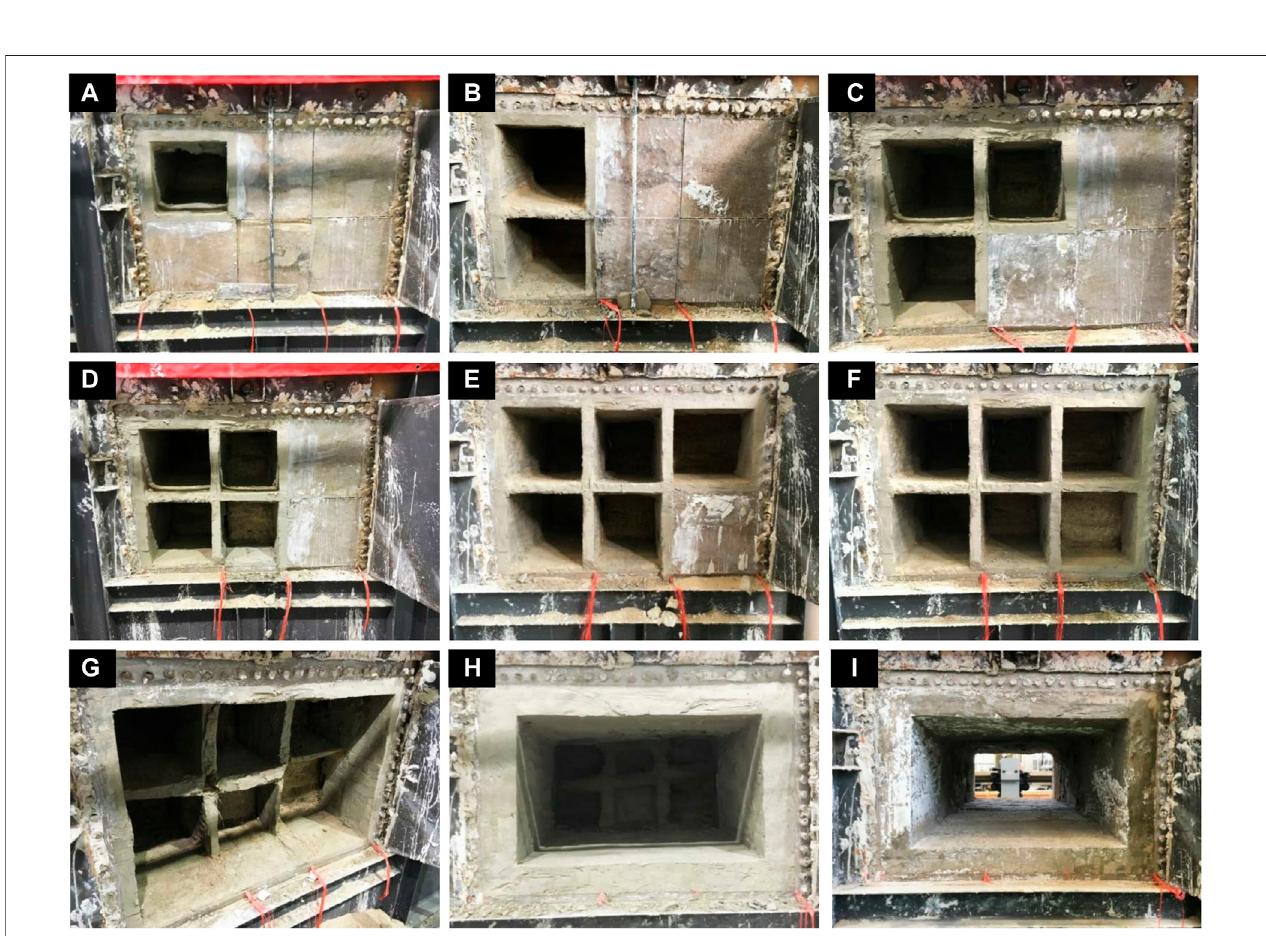
FIGURE9| Experimentalexcavationand primarylininginstallation: (A) Excavationofdrift1; (B) Excavationofdrift2; (C) Excavation ofdrift3; (D) Excavationofdrift 4; (E) Excavation of drift 5; (F) Excavation of drift 6; (G) Dismantle temporary lining; (H) Apply secondary lining; (I) Tunneling completed.